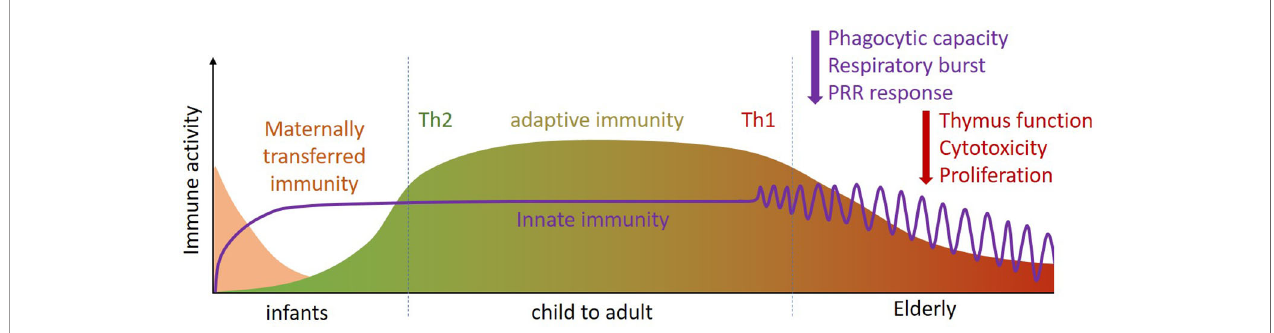
FIGURE 1 | Throughout the life course (infant, child to adult, elderly) the immune system changes in composition and activity. Innate immunity is already present at birth and quickly matures (purple line). For adaptive immune defense infants rely on placental transfer and mothers ’ milk for their fi rst period (pink section). During development, the adaptive immune system phenotype changes from Th2 dominant [i.e. tolerant (green)] to Th1 dominant [i.e. in fl ammatory (red)]. At later age, speci fi c functions of innate and adaptive immunity become less ef fi cient (purple and red arrows). Th,